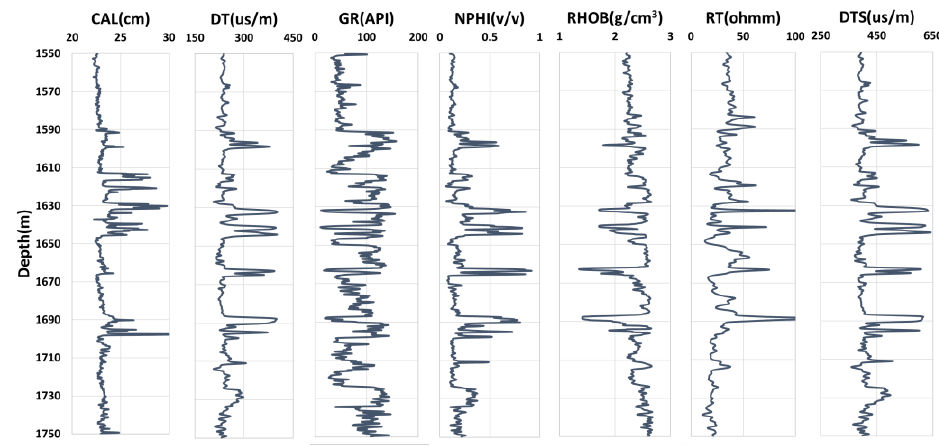
Figure 4. Well logging graph of Well M.